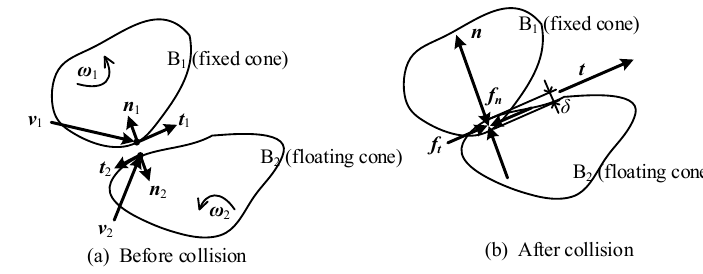
Figure 3. Collision of the fixed cone and floating